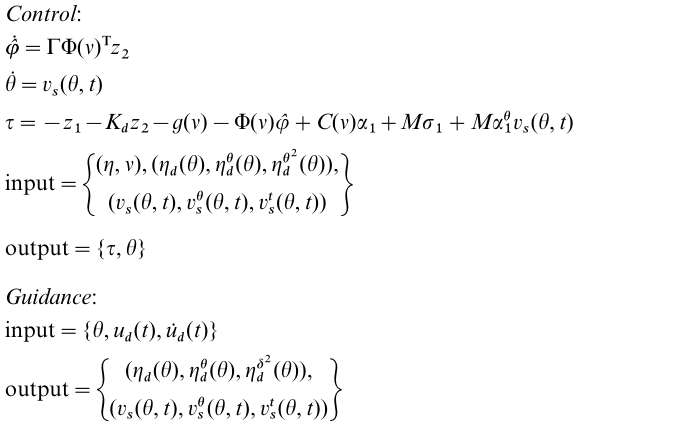
Table 3. Manoeuvering control and guidance system for CyberShip II Control